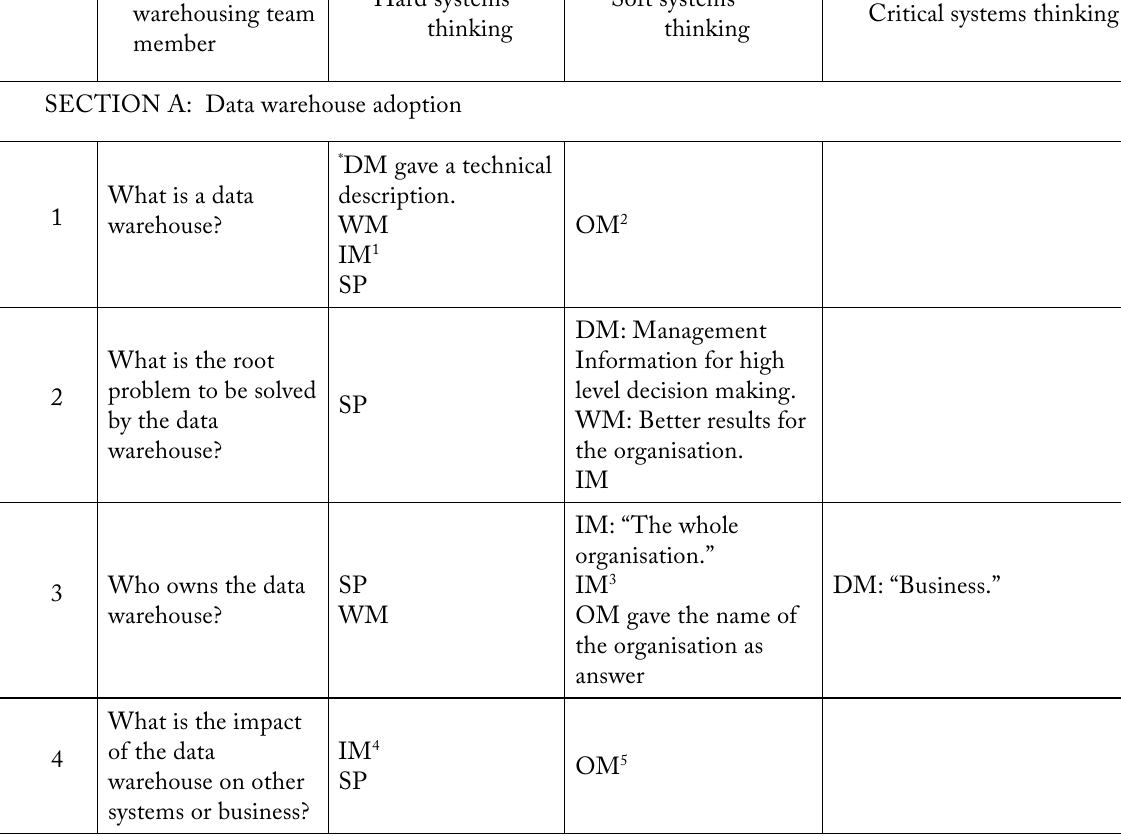
Table 3 Representation of data from one case study Question to